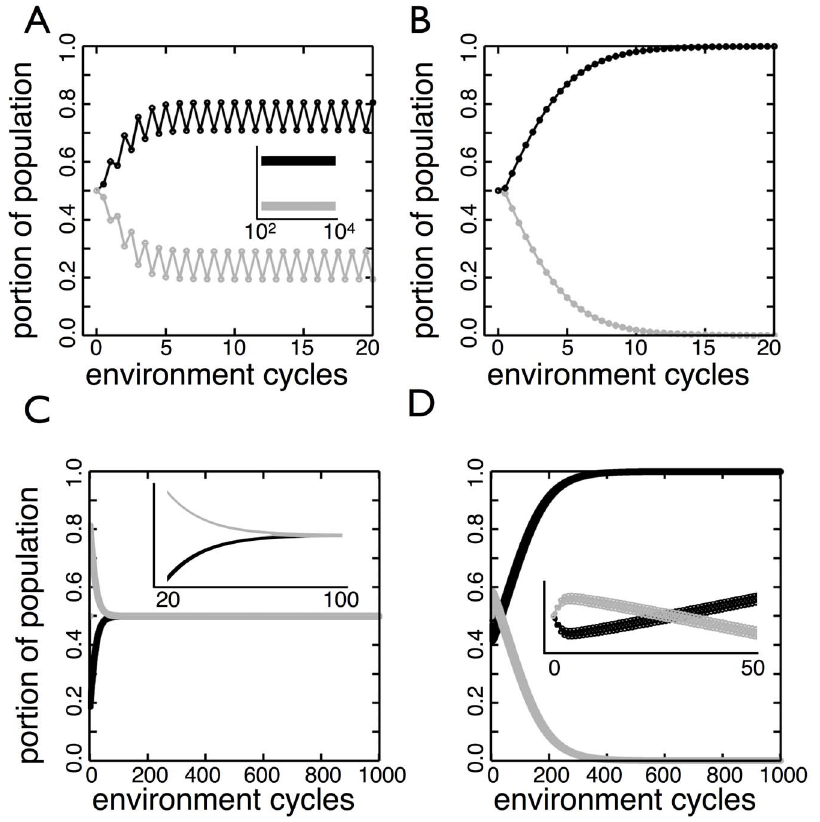
Figure 7. Different behaviors with an imperfect filter between environments. (A) The populations of SW 1 (black) and SW 2 (gray) form a stable oscillation as the environments cycle between E S and E W . The transition probabilities are presented l og 10 in the order of E S p w , E S p s , E W p w , and E W p s . For SW 1 the transition probabilities are f { 3 : 12, { 2 : 47, { 3 : 66, { 5 : 55 g and for SW 2 they are f { 5 : 89, { 5 : 41, { 5 : 04, { 5 : 37 g . (B) SW 1 (black) drives SW 2 (gray) extinct. For SW 1 the transition probabilities are the optimal set using perfect filters f { 1 : 0, { 6 : 0, { 6 : 0, { 1 : 0 g and for SW 2 they are f { 1 : 15, { 5 : 85, { 5 : 85, { 1 : 15 g . (C) SW 1 (black) and SW 2 (gray) monotonically approach the same frequency in the population. For SW 1 the transition probabilities are f { : 43, { 6 : 0, { 6 : 0, { : 43 g and for SW 2 they are the optimal set when perfect filters are used f { 1 : 0, { 6 : 0, { 6 : 0, { 1 : 0 g . (D) SW 1 (black) decreases in frequency for five rounds before changing direction and driving SW 2 (gray) extinct. The transition probabilities for SW 1 are f { 3 : 40, { 3 : 07, { 2 : 33, { 3 : 47 g and for SW 2 they are f { 3 : 13, { 4 : 97, { 3 : 25, { 4 : 04 g .